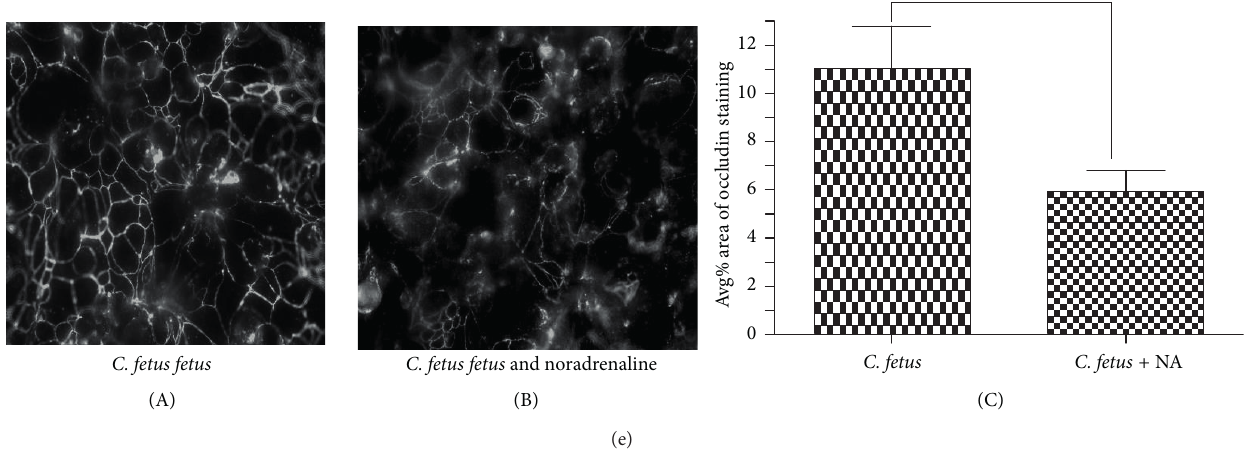
Figure 5: Effect of Campylobacter on integrity of T84 monolayers. Monolayers were fixed and stained for tight junction protein occludin after 48-hour infection with Campylobacter or Campylobacter with NA and analysed by confocal microscopy. Monolayers exposed to C. jejuni 81116, C. jejuni M1, C. coli , and C. fetus fetus in the absence of noradrenaline shown as control in (b)–(e) (A) (the first figure). Cell monolayers co-infected with Campylobacter in the presence of noradrenaline are shown as treated group in (b)–(e) (B) (the second figure). Ten fields of view were visualised using confocal microscopy with a Hamamatsu camera and digitised using Leica Q fluoro software and analysed by quantitative immunofluorescence using Macros on image J software. The average area of percentage area of occludin staining was measured in ten views and compared by an unpaired test ((a)–(e) (C)). Results shown are from a single experiment; ∗ represents 𝑃 value <